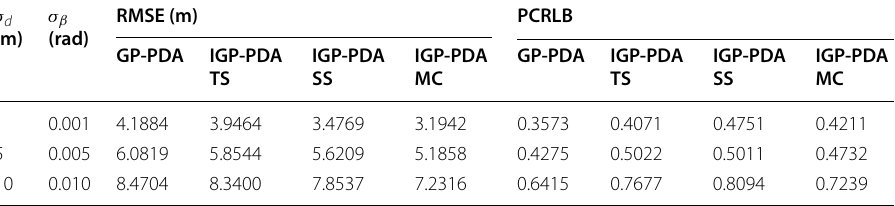
Table 6 Effect of measurement noise on centroid estimates RMSE and PCRLB in the second